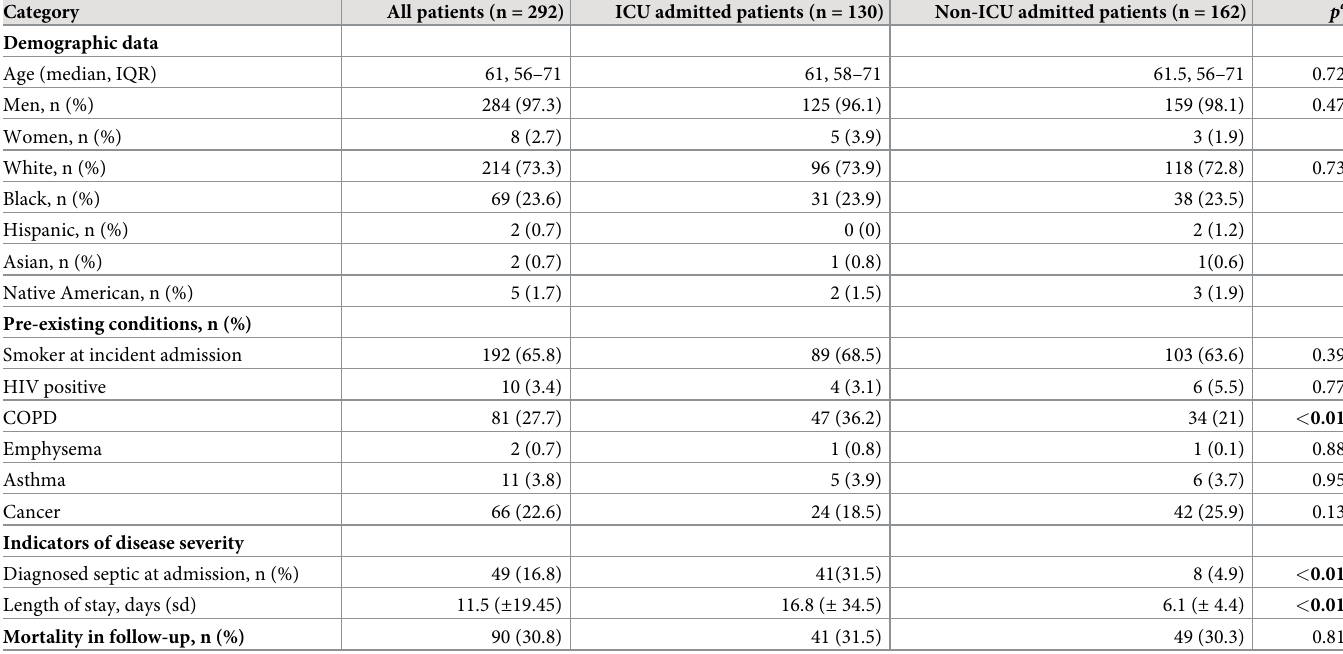
Table 1. Demographics, select medical history, Legionnaires’ disease severity indicators, and mortality of 292 inpatients surviving a hospitalization with labora- tory-confirmed Legionnaires’ disease between 2005–2010 in any U.S. VA medical